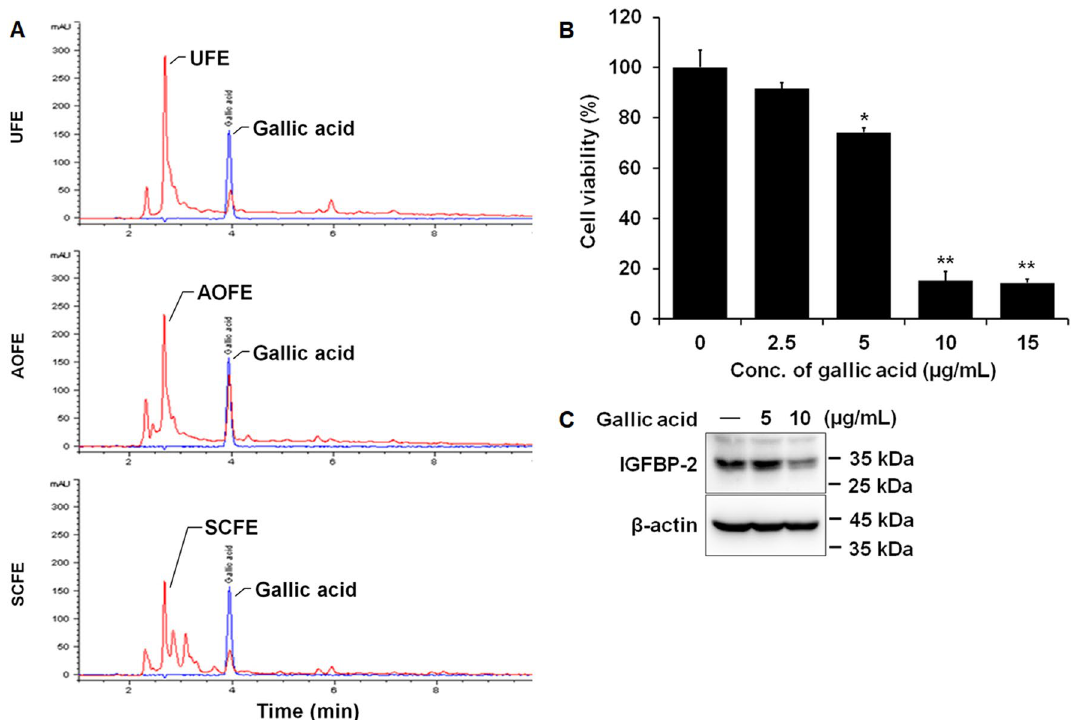
Figure 6. Possibility of regulating the expression of IGFBP-2 by gallic acid with an increase in gallic acid in AOFE. ( A ) The extracts of the CJ dried pericarp were fermented with A. oryzae and S. cerevisiae was analyzed using HPLC. HPLC chromatograms of unfermented extracts (red line), A. oryzae fermented extracts (red line), S. cerevisiae fermented extracts (red line) and gallic acid (blue line). The data are presented as the mean ± SD. FaDu cells were treated with the indicated concentration of gallic acid for 24 h. Cell viability was analyzed by MTT assay ( B ), and expression of IGFBP-2 was analyzed by Western blot ( C ). The data are presented as the mean ± SD. Statistical analyses were performed using paired t-test. * p < 0.05, ** p <